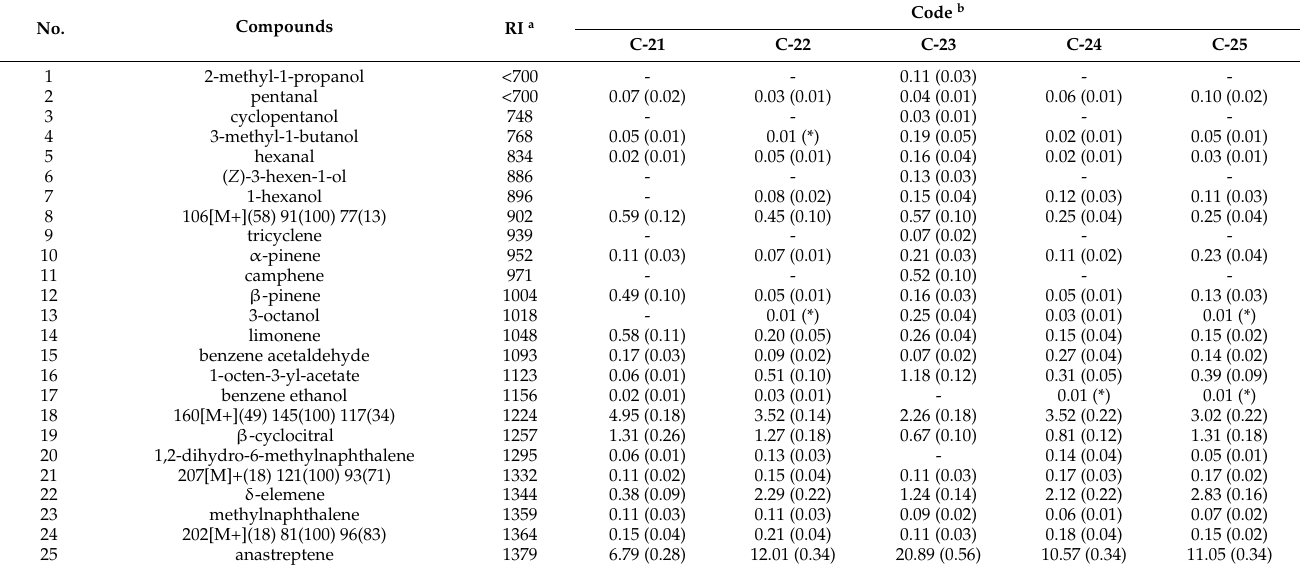
Table 6. Volatile compounds detected in the samples